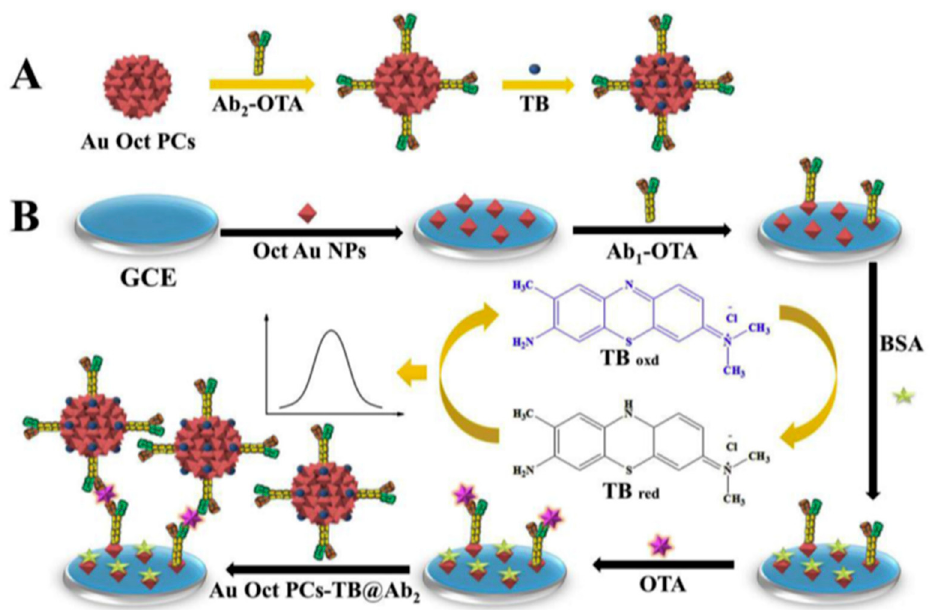
Figure 7. ( A ) Preparation process of AuOCtPCs and ( B ) fabrication steps of the immunosensor for OTA detection. Ab 1 and Ab 2 capture and detector OTA antibodies, respectively. Reproduced from [84], with permission.